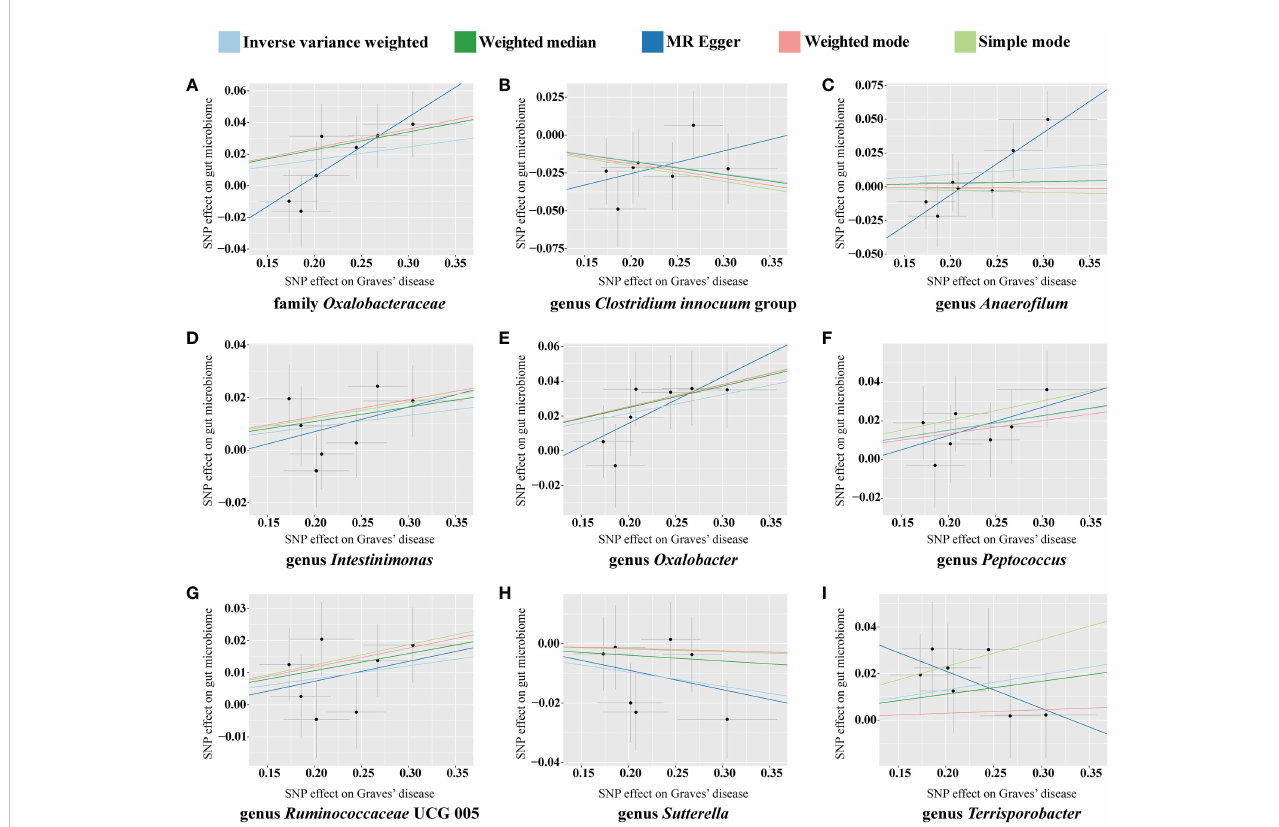
FIGURE 5 Scatterplot of the effect of Graves ’ disease (GD) on the gut microbiome. The effect of the GD on the gut microbiome is calculated through single nucleotide polymorphisms (SNPs), which provide an association between GD and gut microbiome through fi ve Mendelian randomization (MR) methods (A – I) . In each plot, each dot indicates an SNP from the GD genome-wide association study (GWAS) summary dataset. The x -axis values represent the effect of the SNPs on GD. The numerical value of the x -axis position of each dot equals the absolute value of the b -value of each SNP, and the value of the horizontal error bar equals the standard error of SNPs from the GD GWAS summary dataset. The y -axis values represent the effect of the SNP on the gut microbiome. The numerical value of the y -axis position of each dot equals the opposite number of the b -value of the SNP, and the value of the vertical error bar equals the standard error of SNP from the gut microbiome GWAS summary dataset. The b -values and standard errors for SNPs are part of the dataset used to describe the relationship between SNPs and phenotypes; they can be obtained directly by querying the GWAS summary dataset. Different colors of lines represent different MR methods: a causal effect of GD on microbiome was calculated through inverse-variance weighting (IVW) (light blue), weighted median (dark green), MR-Egger (dark blue), weighted mode methods (pink), and simple mode (light green). The value of the slope equals the b-value calculated through the fi ve methods and represents the causal effect of GD on the gut microbiome. The greater the absolute value of the slope, the greater the causal effect. Since the effect allele, an allele to which the effect estimate refers, was identi fi ed in the gut microbiome and the GD GWAS summary dataset, a positive slope indicates that exposure is a risk factor, whereas a negative slope is the